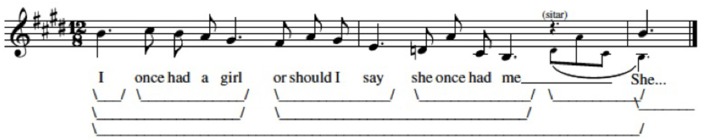
First phrase of Norwegian Wood with its grouping structure from Jackendoff and Lerdahl (2006 p. 38).